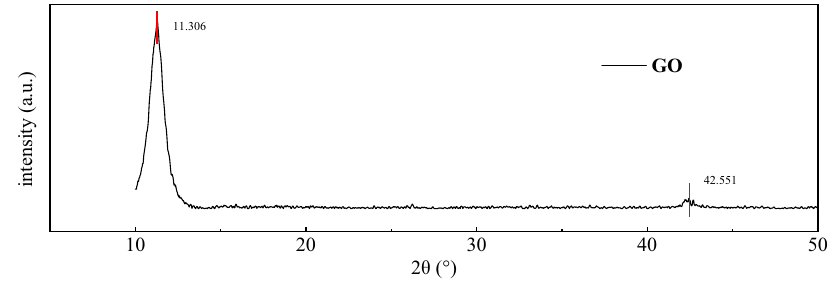
Figure 8: XRD pattern of GO.